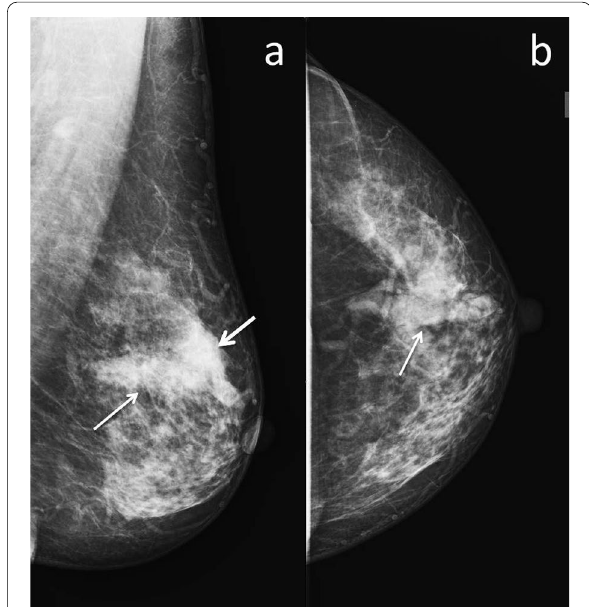
Fig. 1 Mediolateral oblique ( a ) and Cranio caudal ( b ) mammography of the left breast showing high-density mass having an oblong (thin arrow) as well as an irregular mass component (thick arrow) in retroaerolar as well as an upper outer quadrant, involving anterior